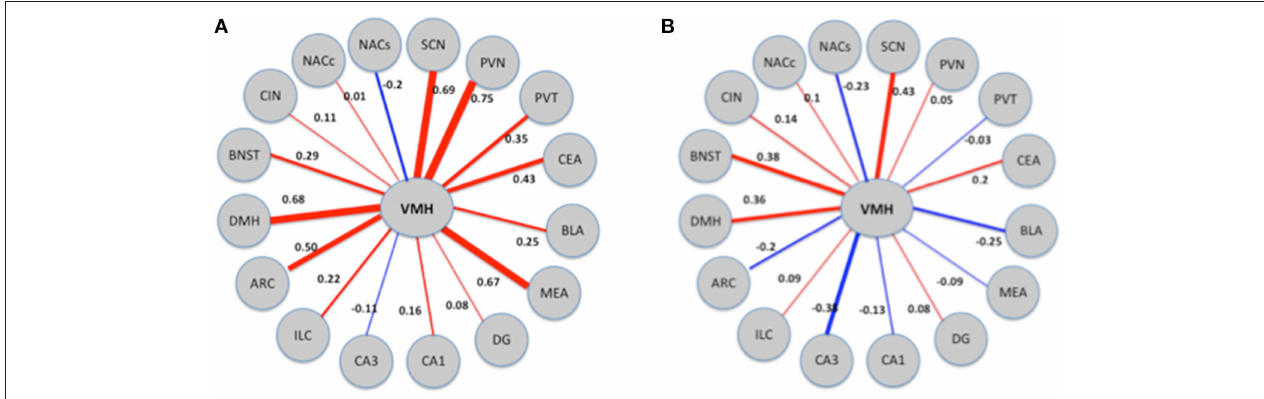
FIGURE 7 | Patterns of connectivity of the VMH region in MA exposed (A) and MA naïve (B) mice. The thickness and color of the edges (red for positive and blue for negative) corresponds to the strength and direction (positive or negative) of the correlations. VMH displays changes in correlations with a number of other regions; the combined effects of these changes is quantified as change in